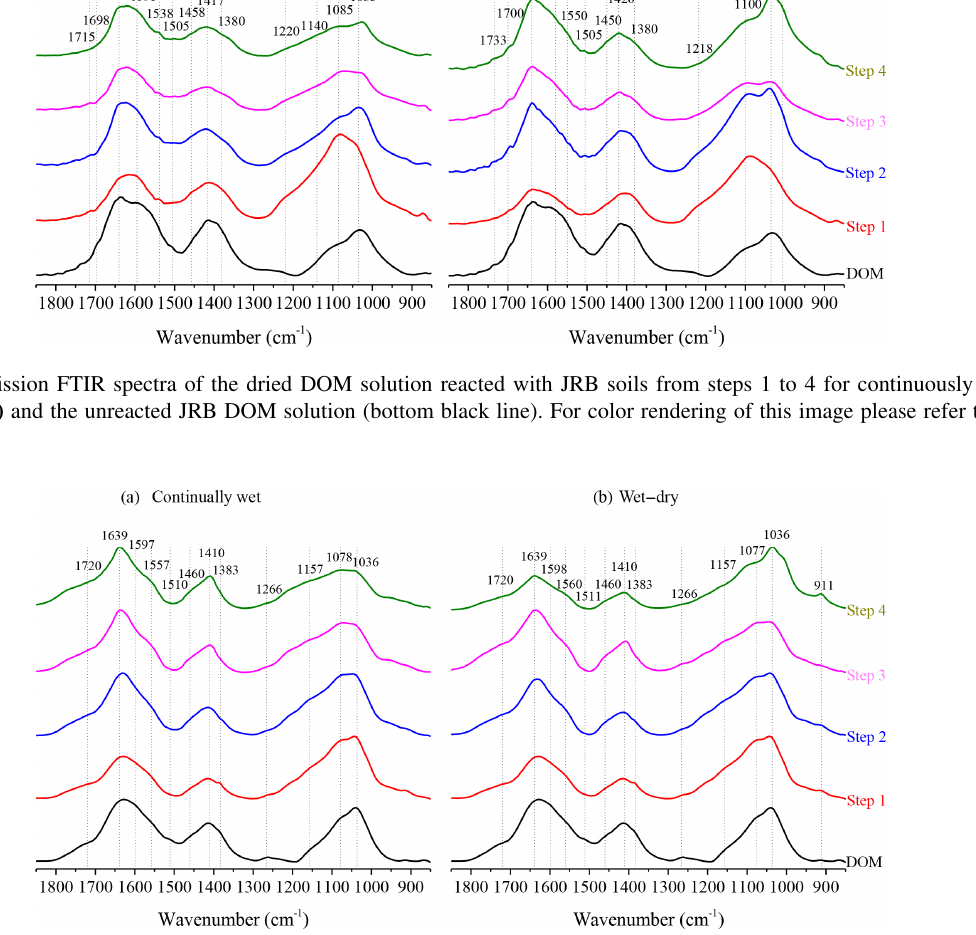
Figure 4. Transmission FTIR spectra of the dried DOM solution reacted with SCM soils from steps 1 to 4 for continuously wet (a) and wet–dry cycles (b) and the unreacted SCM DOM solution (bottom line). For color rendering of this image please refer to the online